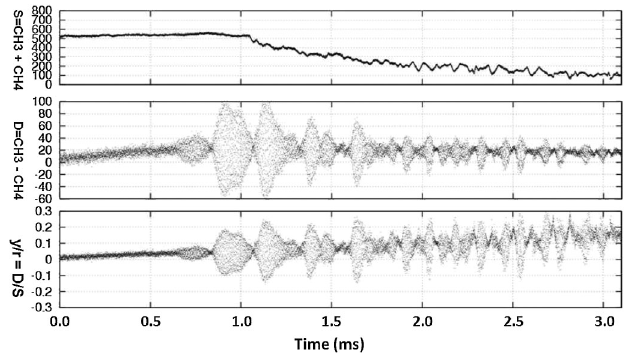
FIG. 9. Intensity and centroid of a slice with width of 5 degrees of rf phase at 212 degrees in the bunch tail for 3.2 ms before extraction. It can be seen that strong oscillations appear before bunch loss occurs. In the figure, t ¼ 0 refers to approximately 11 ms in the cycle.